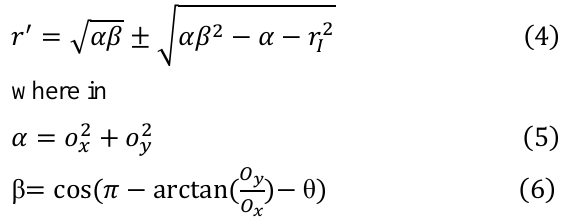
Table 3. Accuracy rate (AR) of iris boundary localization (BL) for three databases.